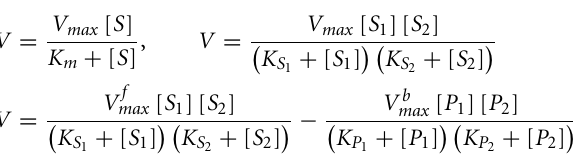
FIGUREA1 | DA metabolism in a DA terminal. Rectangular boxes indicate substrates (see TableA1 ) and blue ellipses contain the acronyms of enzymes or transporters: V Ltyr , L-amino acid transporter; DRR, dihydrobiopterin reductase;TPH, tyrosine hydroxylase; AADC, aromatic amino acid decarboxylase; MAT, vesicular monoamine transporter; DAT, DA reuptake transporter; auto, DA autoreceptors;